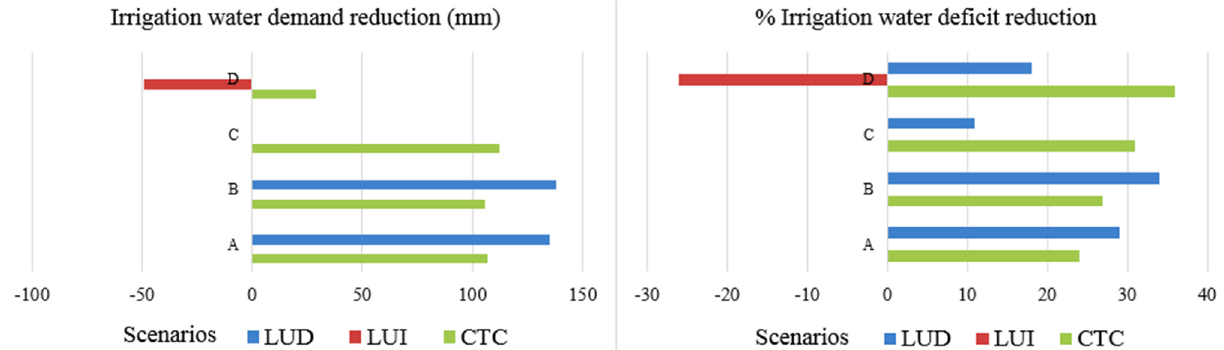
Figure 7. Effects of land use scenarios LUD (land use decrease), LUI (land use increase) and CTC (crop type change), with irrigation water demand reduction and % irrigation water deficit reduction as indicators in sub-catchments